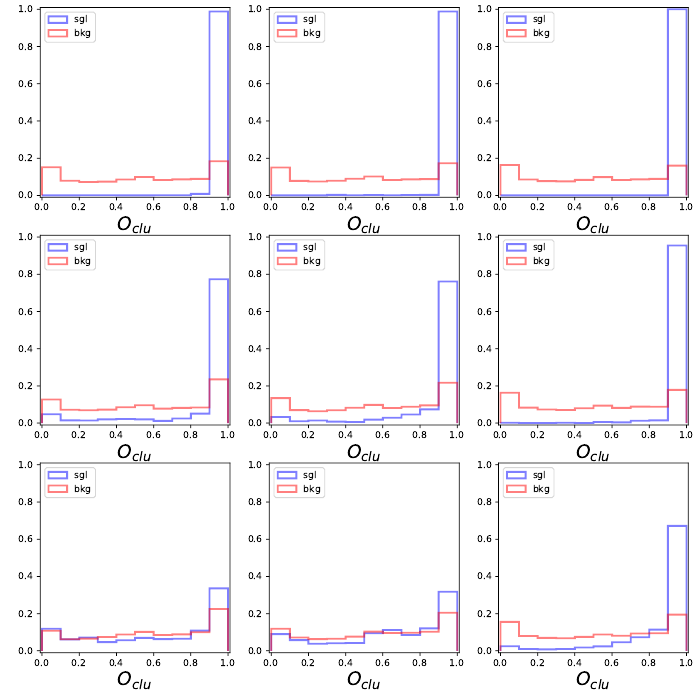
Figure 20 . Novelty score according to O clu for the 2D Gaussian testing samples corresponding to the same BPs as in figure